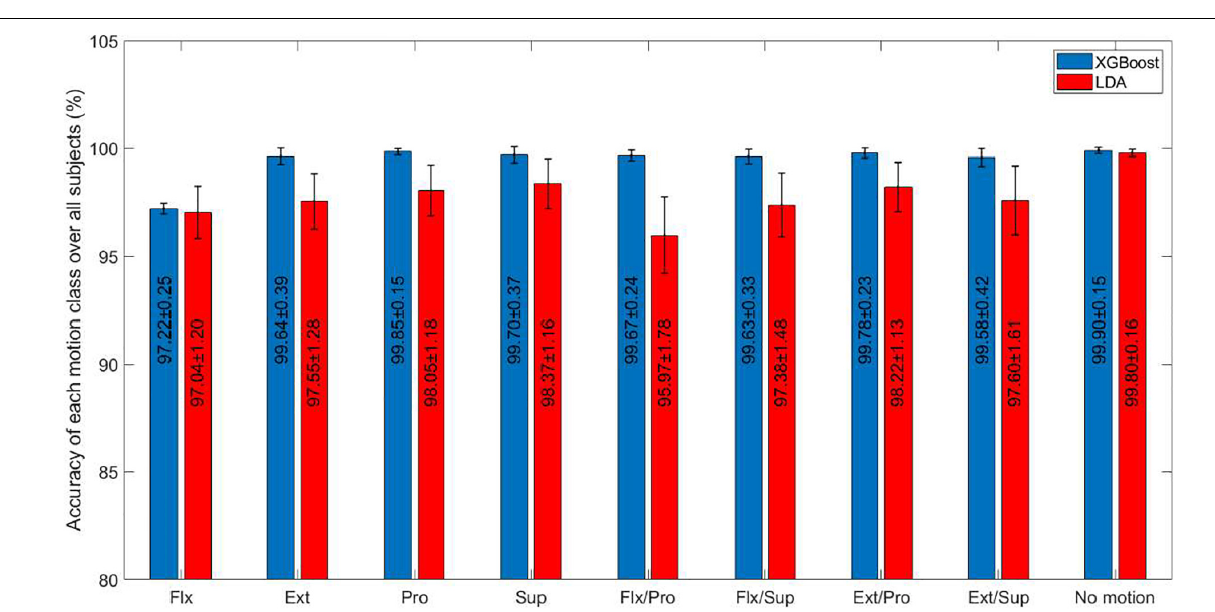
FIGURE 6 | The comparison between the performance of the eXtreme gradient boosting (XGBoost) and linear discriminant analysis (LDA) classifiers for each movement class. Error bars show standard deviation over the test folds. Flx, Flexion; Ext, Extension; Pro, Pronation; Sup,